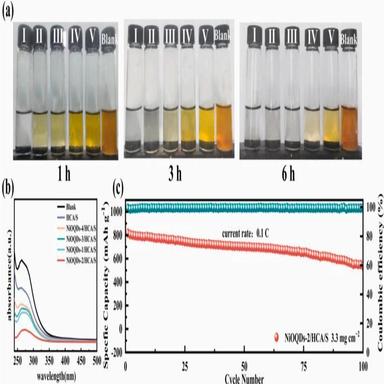
(a) Photographs of different composites absorbed in Li2S6 solution; (b) UV–vis spectra for polysulfide solution adsorbed by different composites; (c) Cycling stability performances of NiOQDs-2/HCA/S cathodes with sulfur loading of 3.3 mg cm− 2 at 0.1 C.